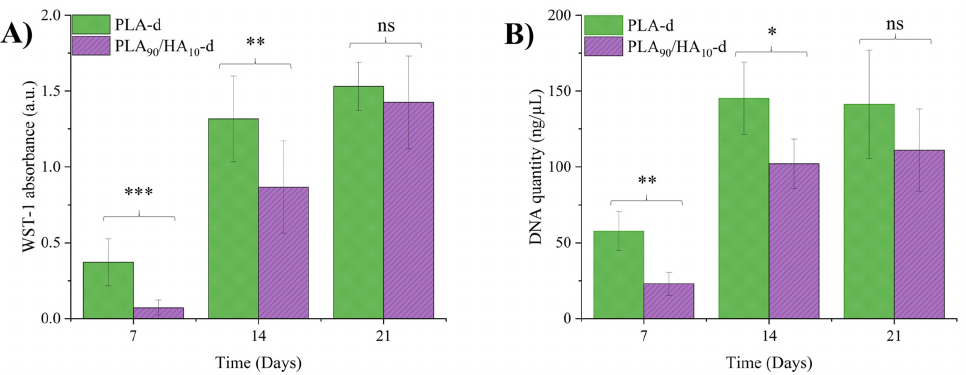
Figure 7 . WST-1 absorbance ( A ) and DNA quantification ( B ) of MSCs on day 7, day 14, and day 21 of culture in PLA-d and PLA 90 /HA 10 -d scaffolds (mean ± SD). Mann–Whitney test, * p < 0.05, ** p < 0.005, *** p < 0.0005, ns = non-significant.